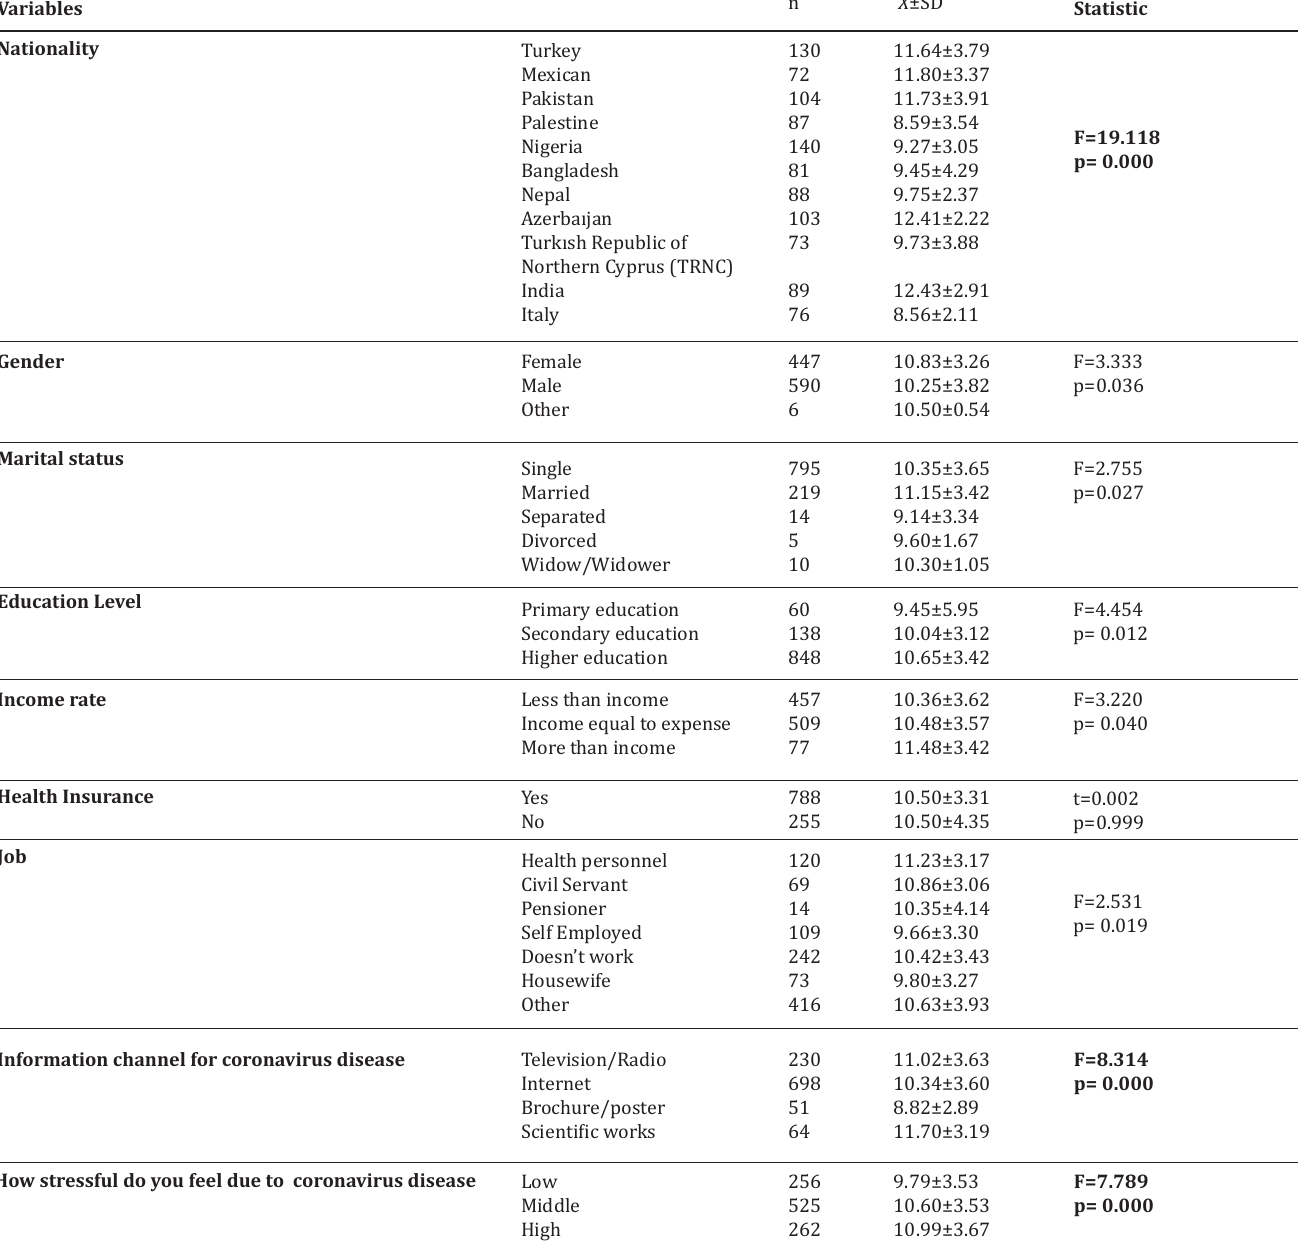
Comparison of Individuals' Demographic Characteristics and Knowledge Level Points for Coronavirus Disease